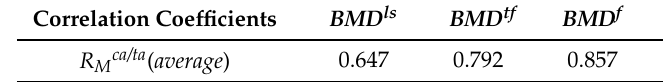
Table 4. Correlation coefficient r values of R Mca/ta ( average ) with BMD ls and BMD tf , respectively.